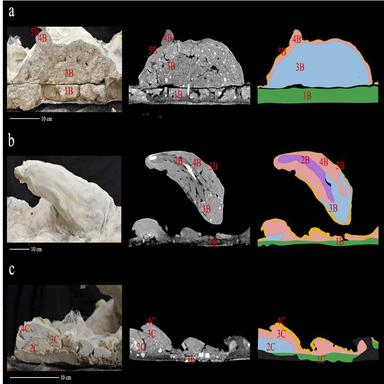
CT model of the fragment of the eagle: in the first column the VIS light image, in the second column the Rx scan of the same parts and in the third column a colored graphic reconstruction. a. Stratigraphic sequence of the body of the eagle: the arriccio (1B), the first ground layer (3B), the second ground layer (4B) and the finishing layer (5B) can be observed. The anchoring metal bar is visible between the level 1B and 3B. b. Stratigraphic sequence of the eagle's head where it is possible to observe the hi